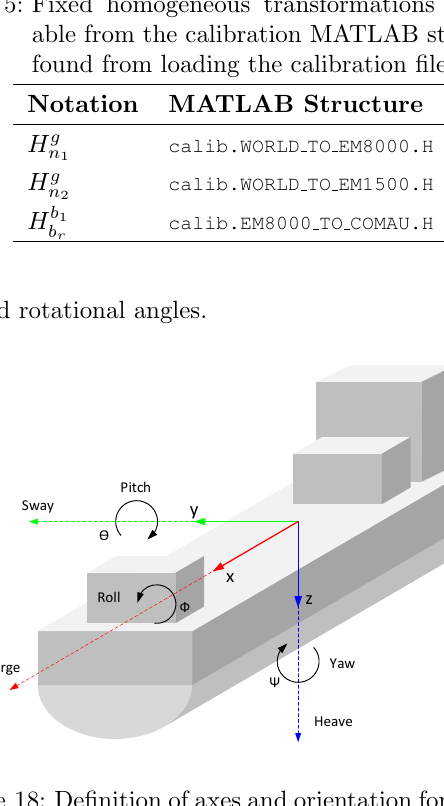
Figure 18: Definition of axes and orientation for vessels out at